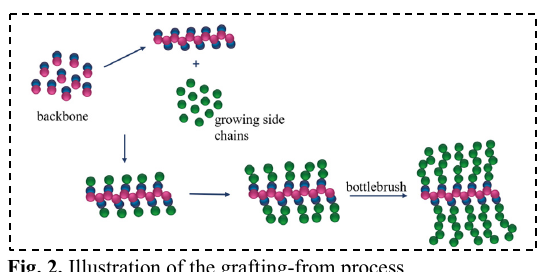
Fig. 2. Illustration of the grafting-from process.